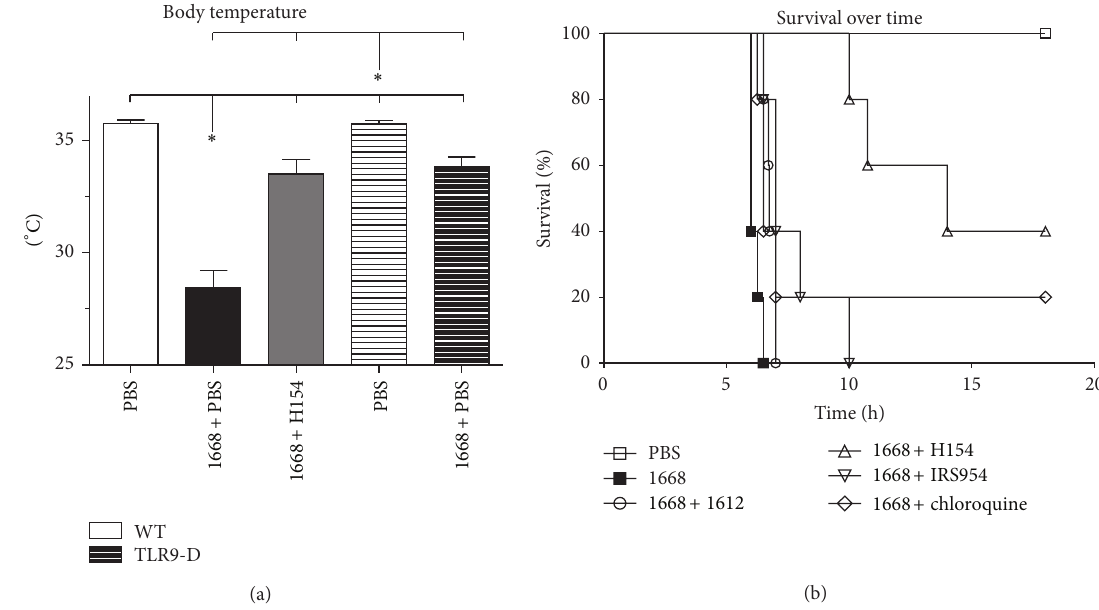
Figure 2: (a) Body temperature of WT- and TLR9-D mice6 h after stimulation with the TLR9 agonist 1668-thioate. The TLR9 inhibitor H154- thioate was administered 30 min after stimulation. PBS application served as control. Bars of TLR9-D are striated (mean ± SEM; 𝑛 = 8 /group, ∗ 𝑃 < 0.05 ; ∗ also indicates the significant group). (b) Survival over time of WT mice after stimulation with the TLR9 agonist 1668-thioate alone or in combination with the control ODN 1612-thioate or the TLR9 inhibitors H154- and IRS954-thioate as well as chloroquine. Inhibitors were injected i.v. 30 min after stimulation. PBS application served as control ( 𝑛 = 6